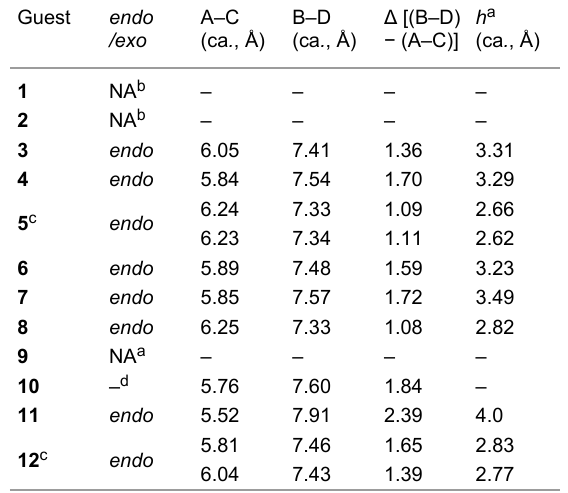
Table 1: Summary of solid-state host–guest endo / exo complexations, and cavity conformation flexibility in BrC6.